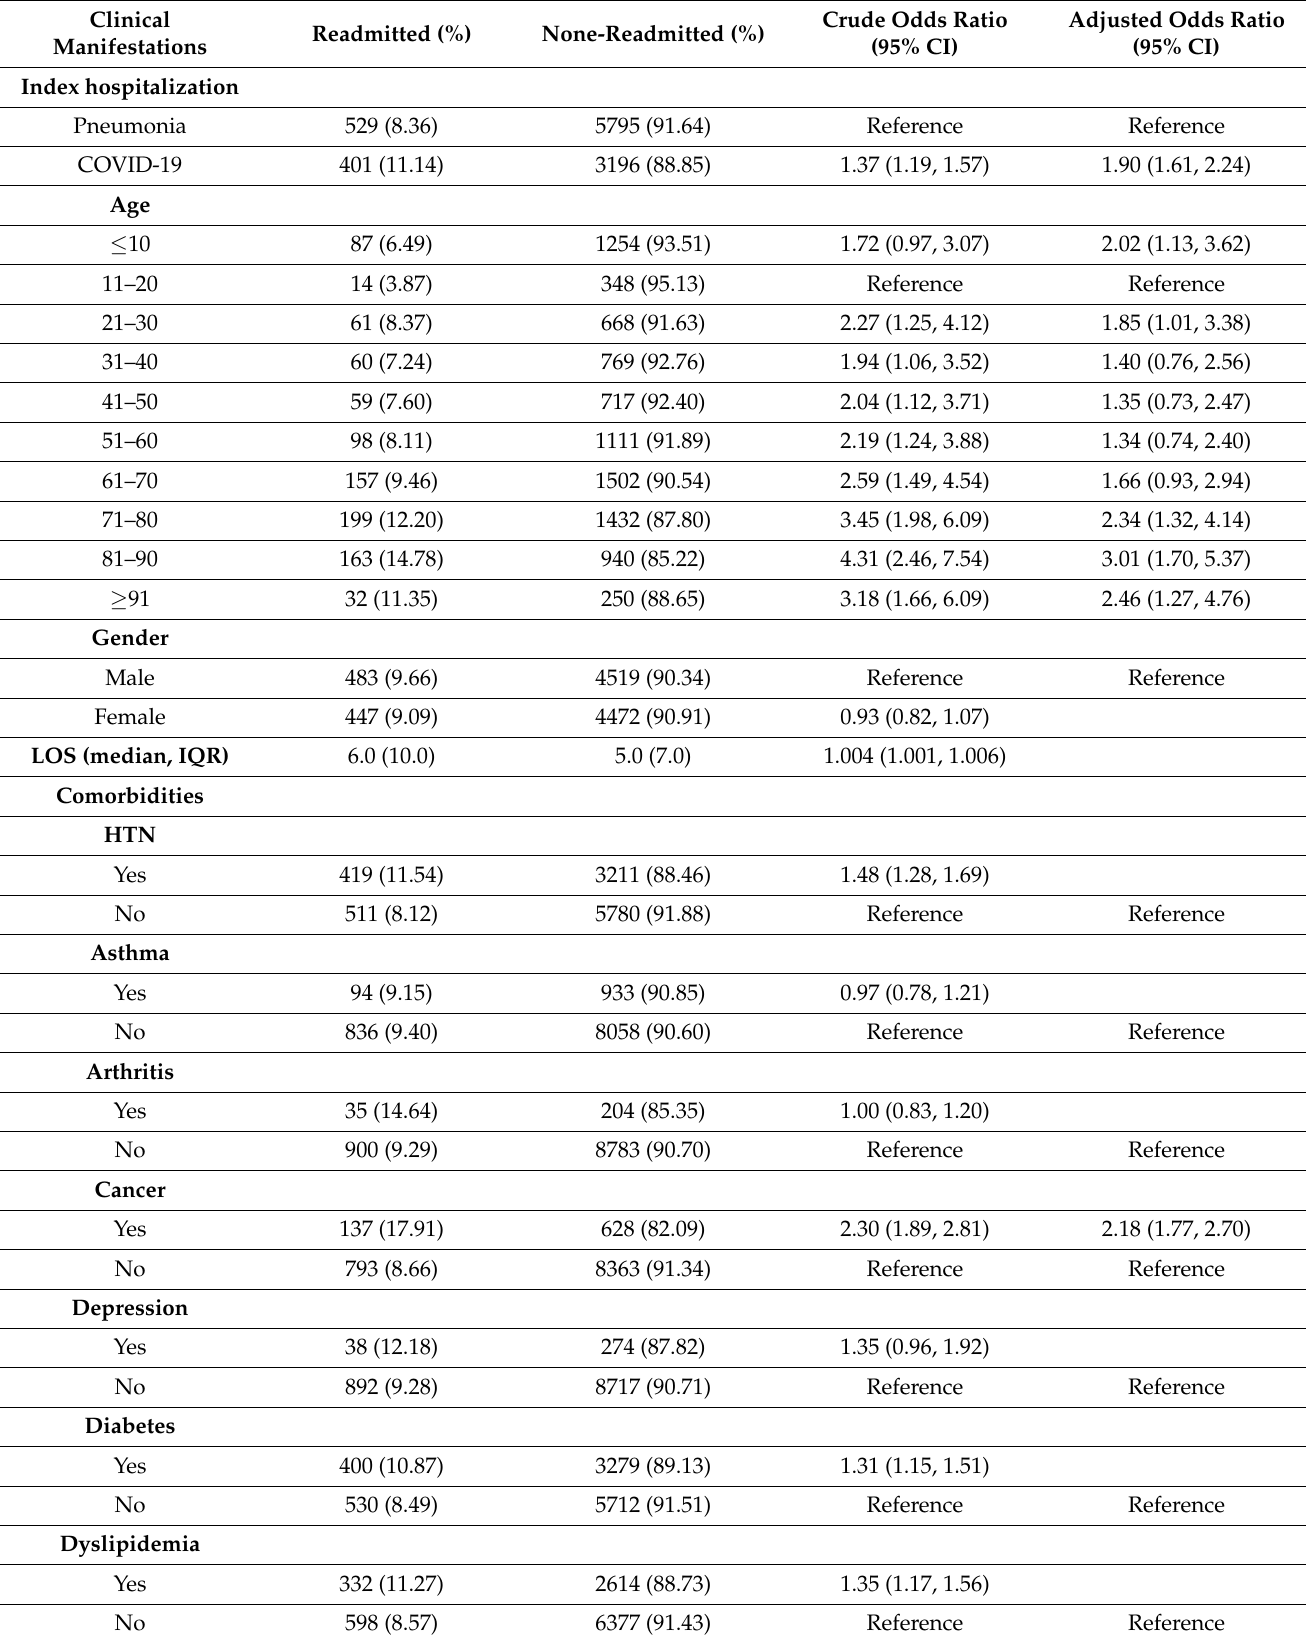
Table 5. Univariate and multivariate analysis for 30-day hospital readmission among patients discharged from hospital with COVID-19 and pneumonia, NGHA, Saudi